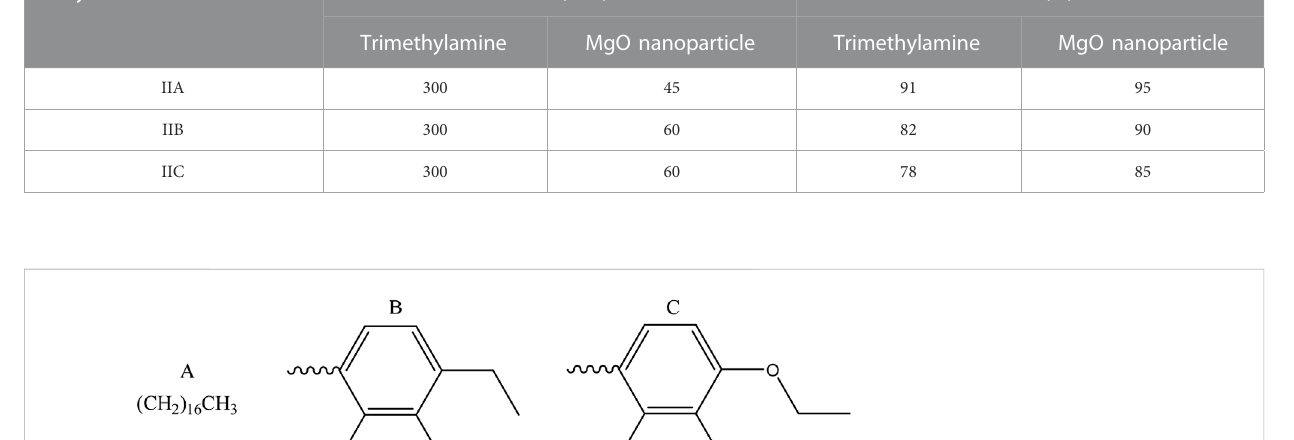
TABLE 2 Comparison of different methods for the synthesis of three derivatives. Synthesized derivative